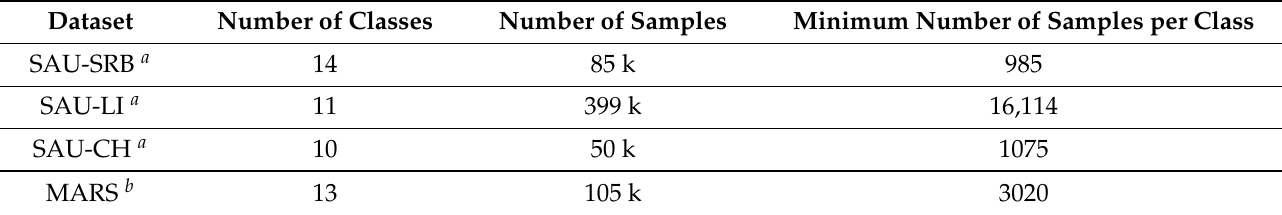
Table 1. Datasets